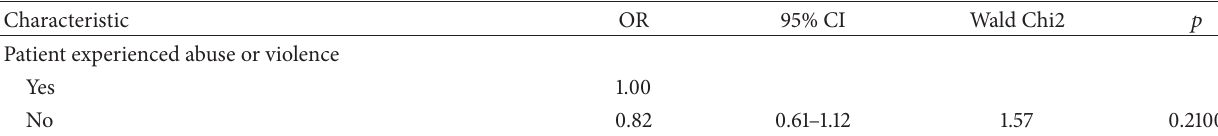
(b) Results of logistic regression analysis with impulsiveness related patient